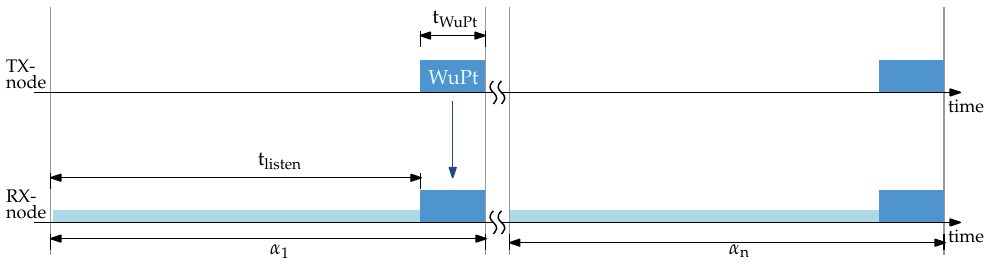
Figure 4. Signal timings of wake-up